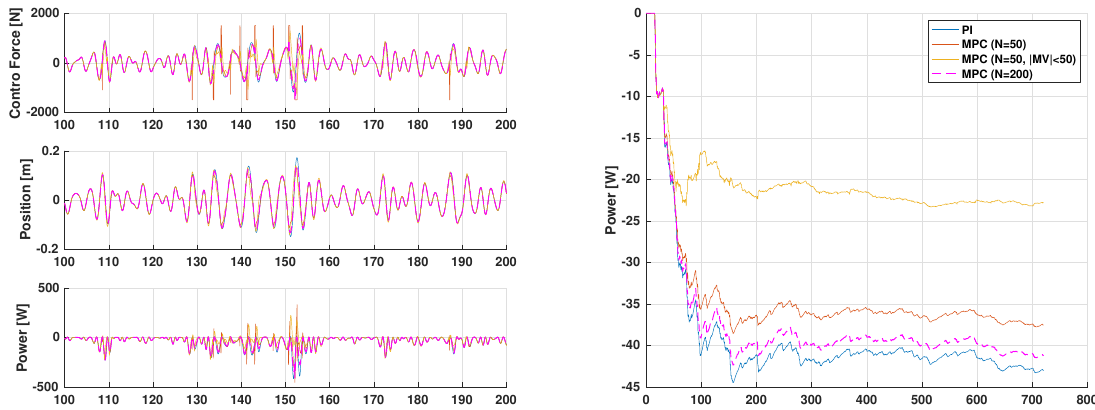
Figure 5. Comparison of the control forces, positions, power absorptions, and cumulative average power obtained by the PI controller and the MPC (scenario 3). Table 3. Comparison of results for Scenario